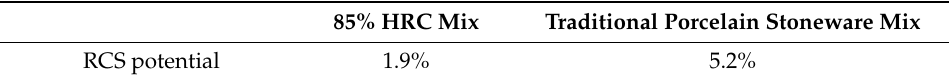
Table 7. Respirable fraction of Crystalline Silica (RCS) of the traditional and 85% HRC spray-dried powders.